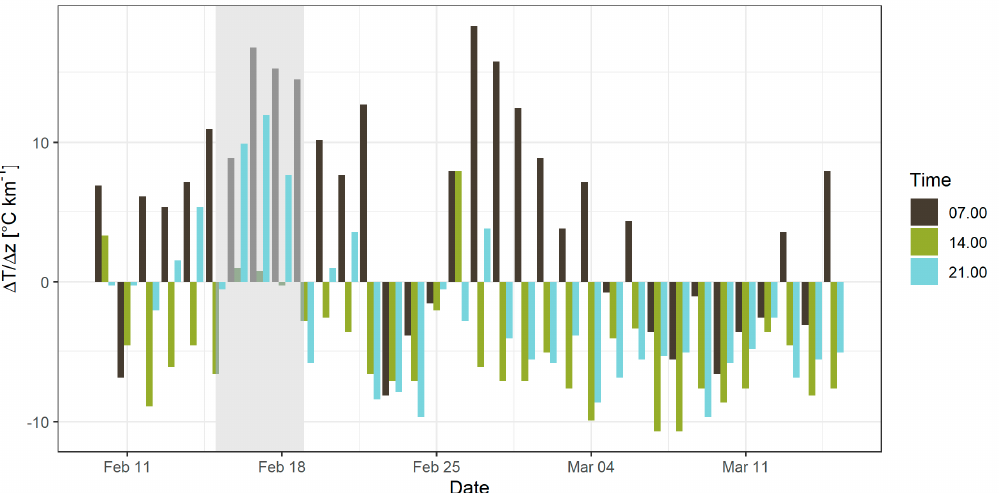
Figure 3. ∆ T/ ∆ z between Bežigrad and Topol stations from 10 February to 15 March 2019. Period with persistent ATI shaded in grey.